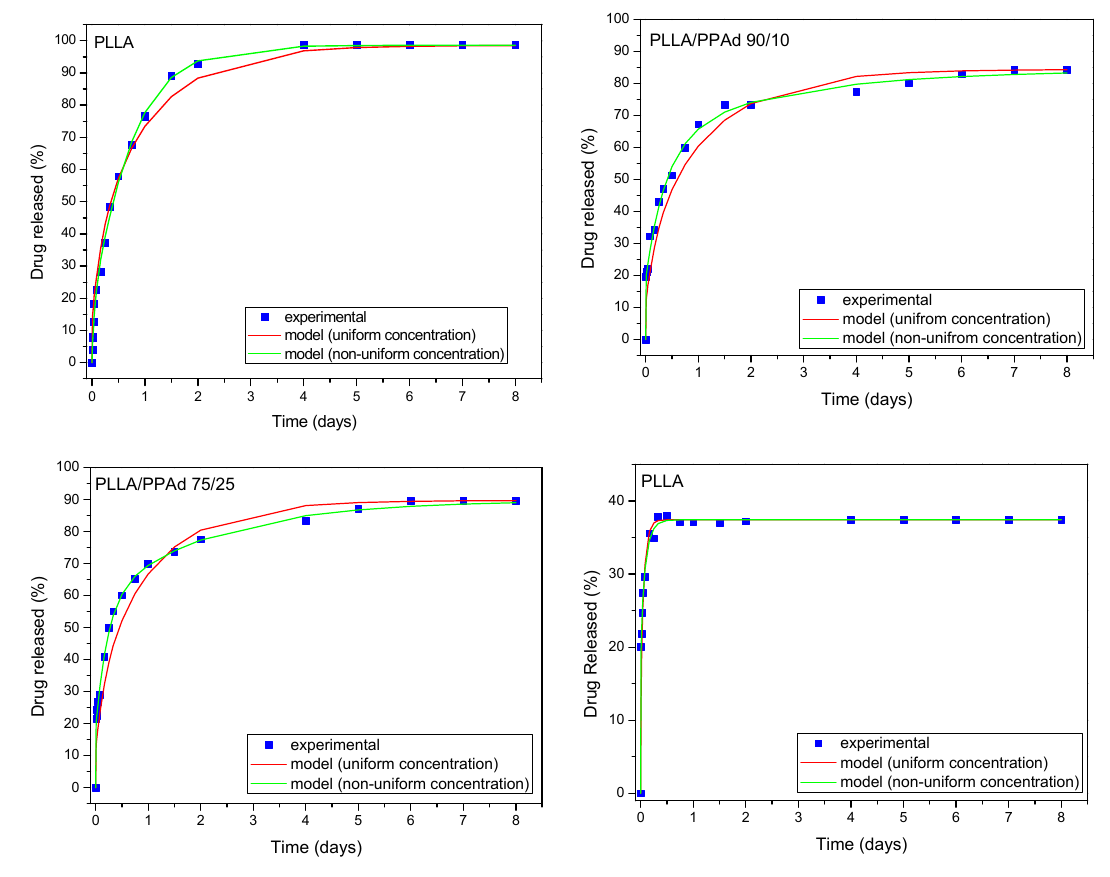
Figure 16. Experimental and model (for uniform and non-uniform drug profile) release curves.